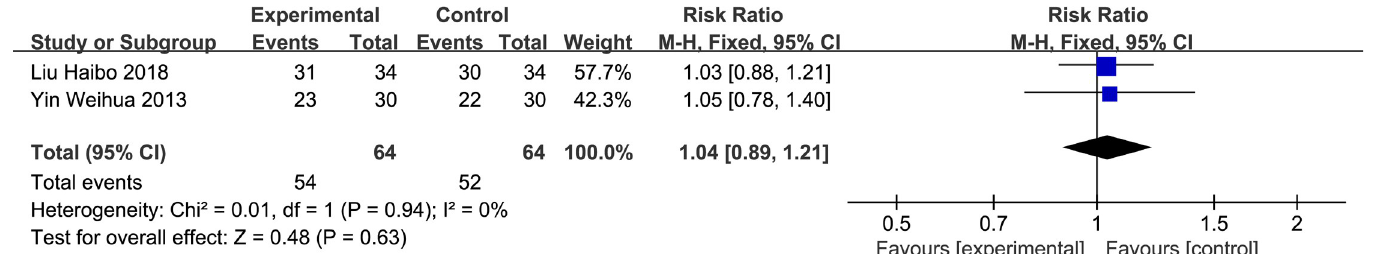
Fig 11. Forest plot of the KPS scores between experimental and control group.